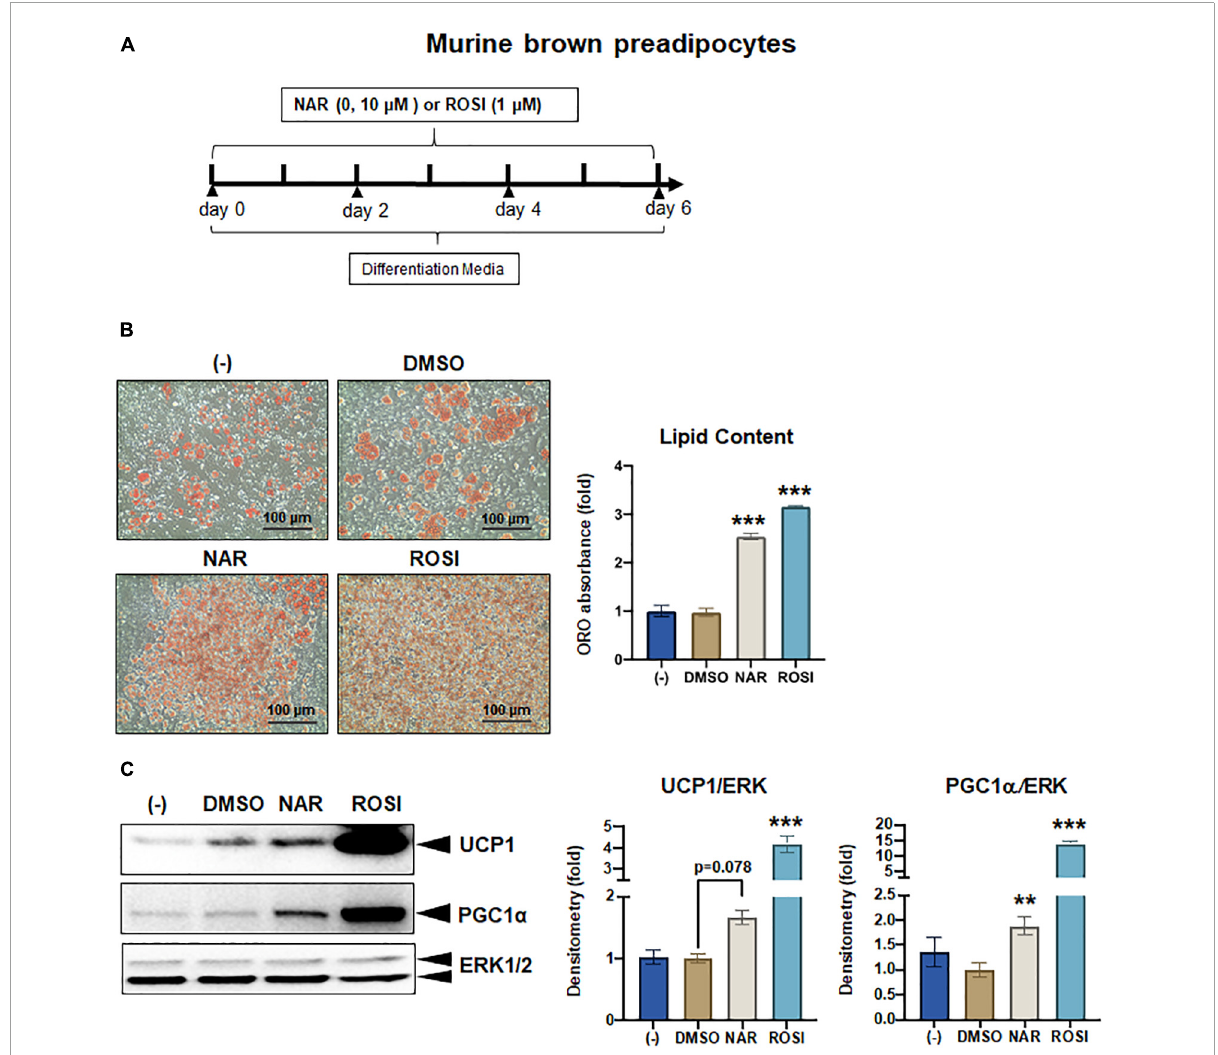
FIGURE6 Naringenin promotes brown adipogenesis and thermogenic protein expression in murine brown adipocytes. Murine brown pre-adipocytes were differentiated in the presence or absence of NAR (10 µ M) or ROSI (1 µ M) for 6 days. (A) A diagram of the cell treatment and timeline. (B) Oil red O (ORO)-stained cell morphology and ORO absorbance. Scale bar = 100 µ m. (C) Protein expression of thermogenic genes UCP1, PGC1 α , and the loading control ERK1/2. Bar graphs show the densitometry of each protein normalized to the loading control ERK1/2. Data = Mean ± SEM ( n = 3). *, **, *** p < 0.05, p < 0.01, and p < 0.001 compared to the DMSO samples,